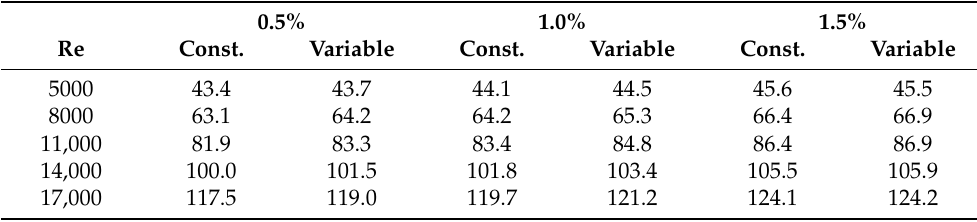
Table 7. Nu numbers for constant and variable properties of constant HF.